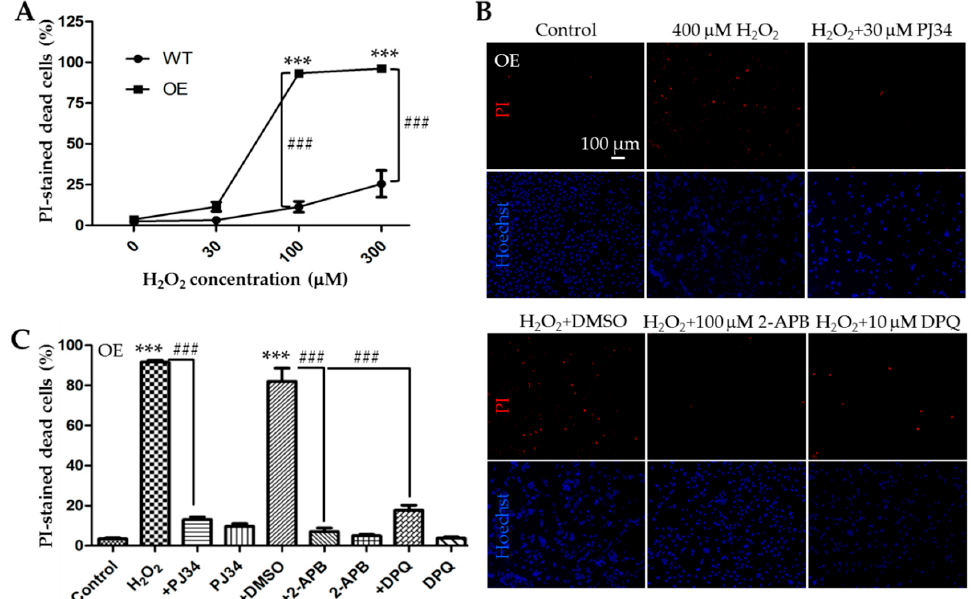
Figure 4. Increasing the TRPM2 expression in SH-SY5Y cells augments the susceptibility to H 2 O 2 -induced cell death. ( A ) Mean ± SEM percentage of PI-positive cells in the WT and TRPM2-overexpressing (OE) cells after exposure to indicated concentrations of H 2 O 2 from three independent experiments. ***, p < 0.001, compared to cells without exposure to H 2 O 2 in the OE cells; ###, p < 0.001 compared between the WT and OE cells exposed to the same concentration of H 2 O 2 . ( B ) Representative fluorescence images showing staining with PI and Hoechst in the OE cells treated with indicated inhibitors, 30 min before and during exposure to 400 µ M H 2 O 2 for 24 h. ( C ) Mean ± SEM percentage of PI-positive cells under indicated conditions in the OE cells from three independent experiments. ***, p < 0.001 compared to control cells; ###, p < 0.001 compared to cells treated with H 2 O 2 alone or treated with H 2 O 2 and